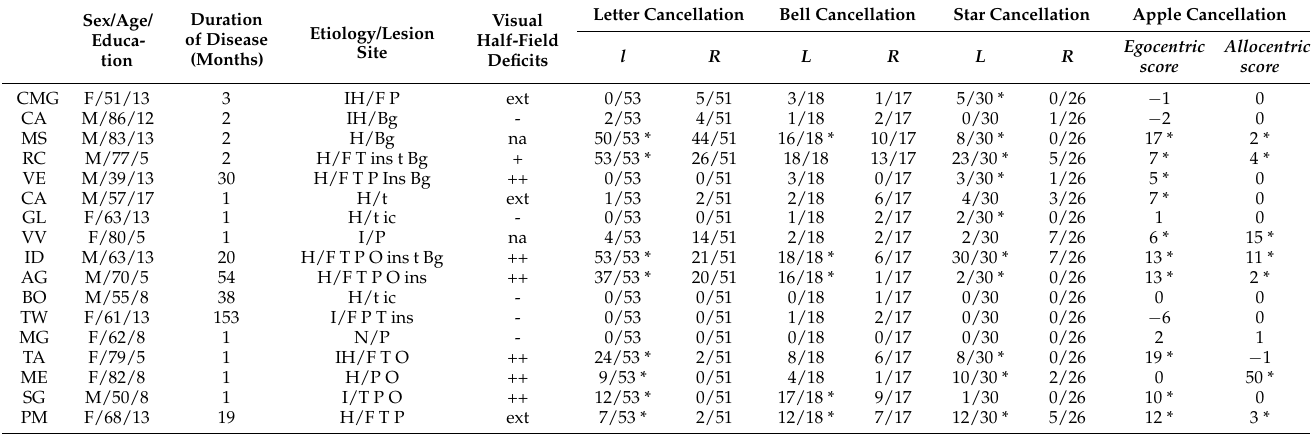
Table 4. Demographic and neurological data of the 17 right-brain-damaged patients included in